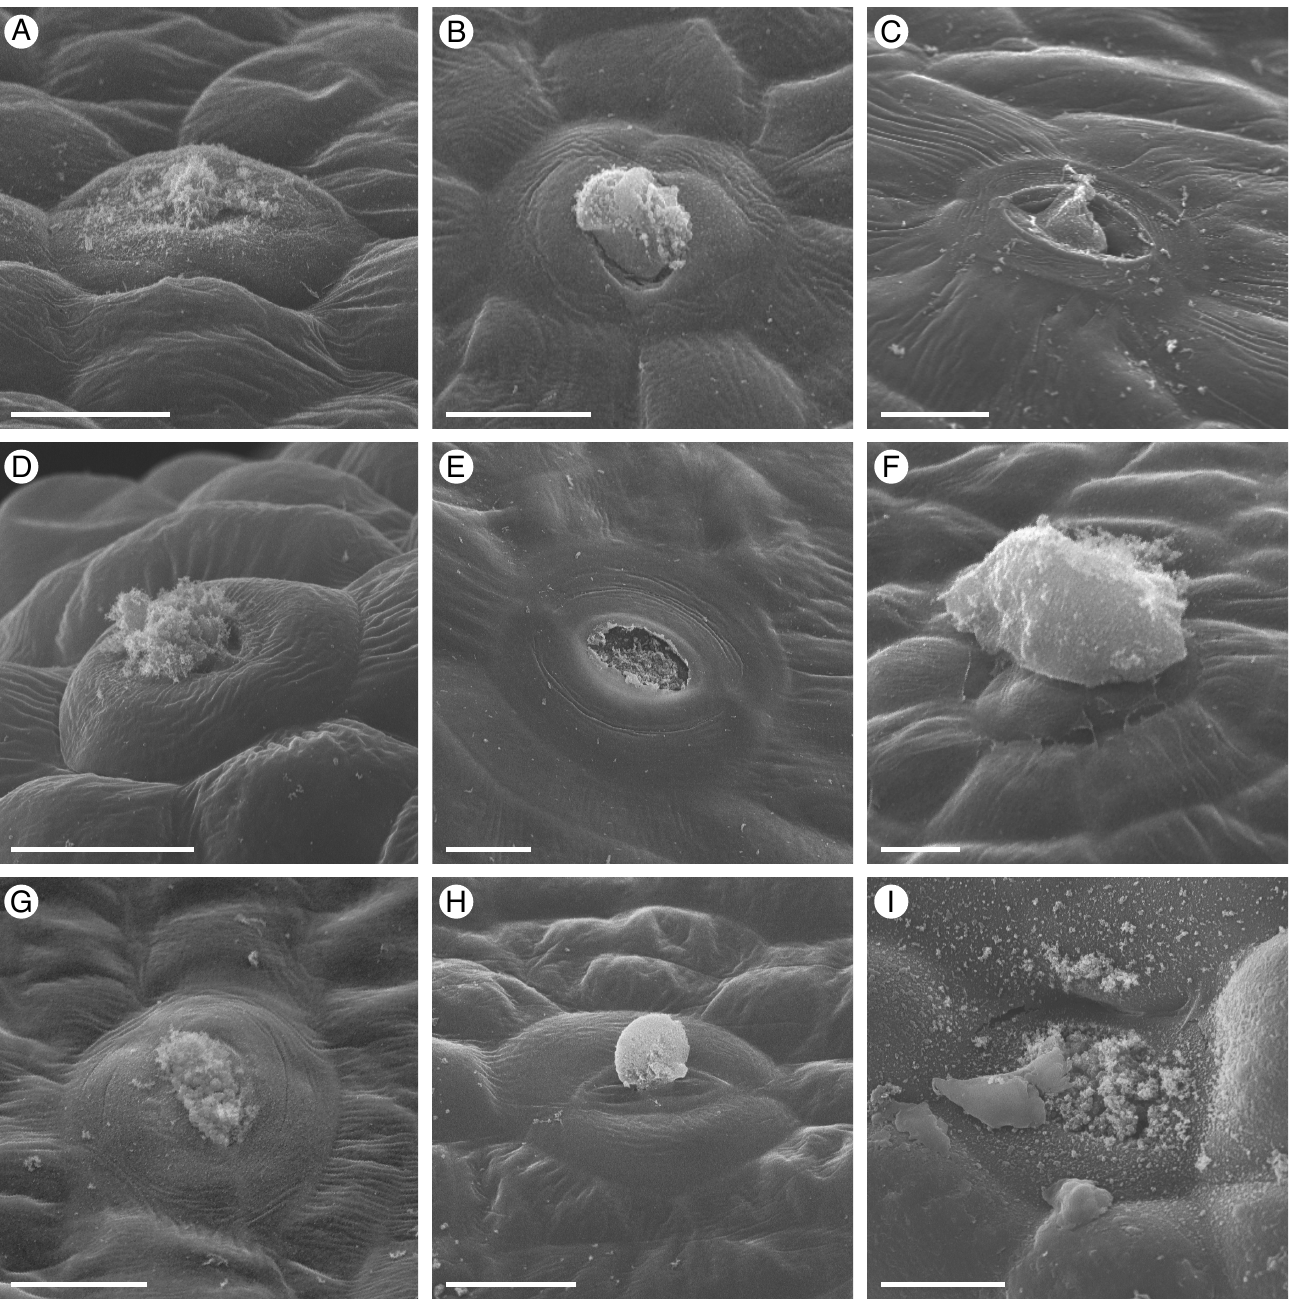
Figure 11. Nectarostomata of the nine Cleomaceae species. ( A ) Arivela viscosa . ( B ) Cleome amblyocarpa . ( C ) Cleome violacea . ( D ) Gynandropsis gynandra . ( E ) Melidiscus giganteus . ( F ) Polanisia dodecandra . ( G ) Sieruela hirta . ( H ) Sieruela rutidosperma . ( I ) Tarenaya houtteana . All images are of anthetic stage specimens, except C . amblyocarpa (intermediate stage) and G . gynandra (bud stage). Scale bar represents 10 µ